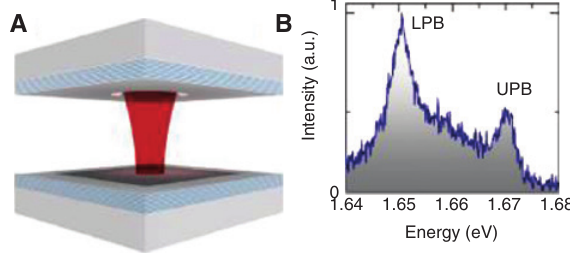
Figure 7: Exciton-polaritons in layered materials. (A) Schematic of the open distributed Bragg reflector (DBR) cavity with layered material inside the cavity. The top mirror of the cavity can be mechanically displaced to tune the cavity resonance. (B) Pho- toluminescence spectrum of the strongly coupled exciton-polariton system clearly shows the upper and lower polaritons. The figures are reprinted from Ref.